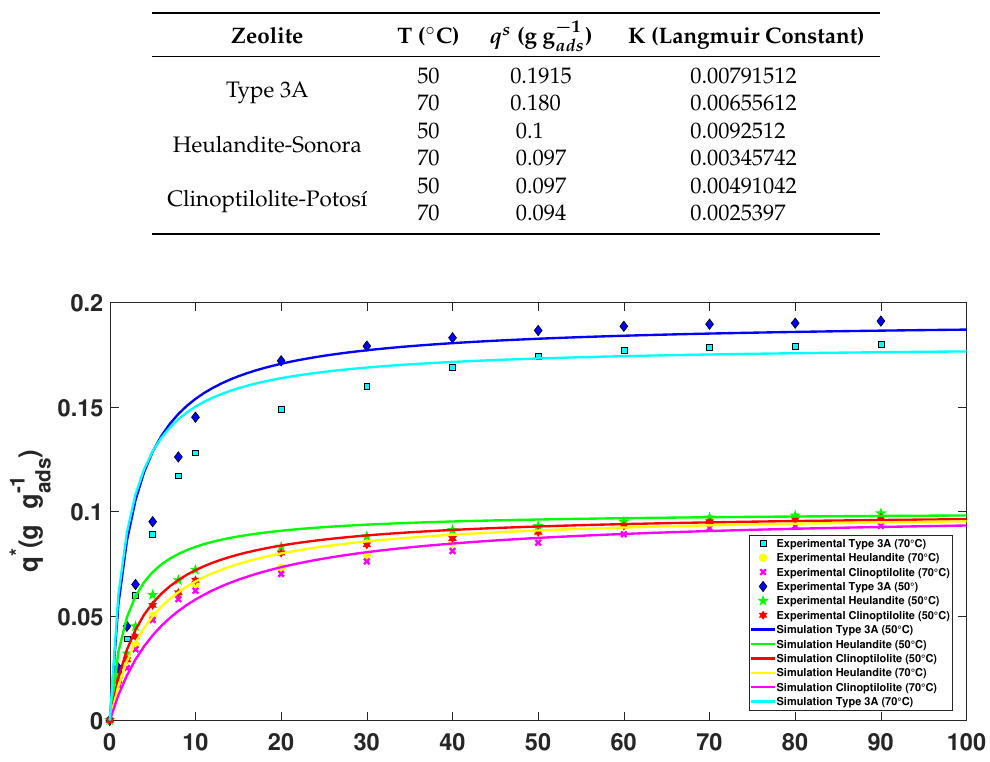
Values of the thermodynamic constants as a function of temperature for the H 2 O / C 2 H 5 OH mixture.